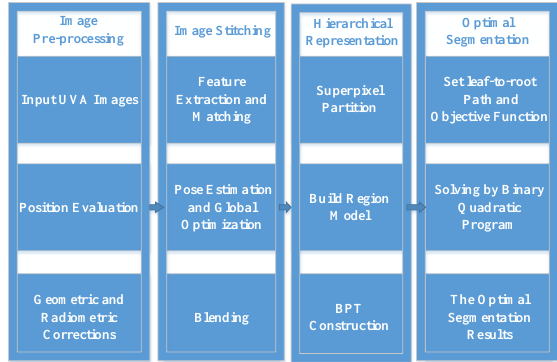
Figure 1. The integrative object-based image analysis framework for UAV images